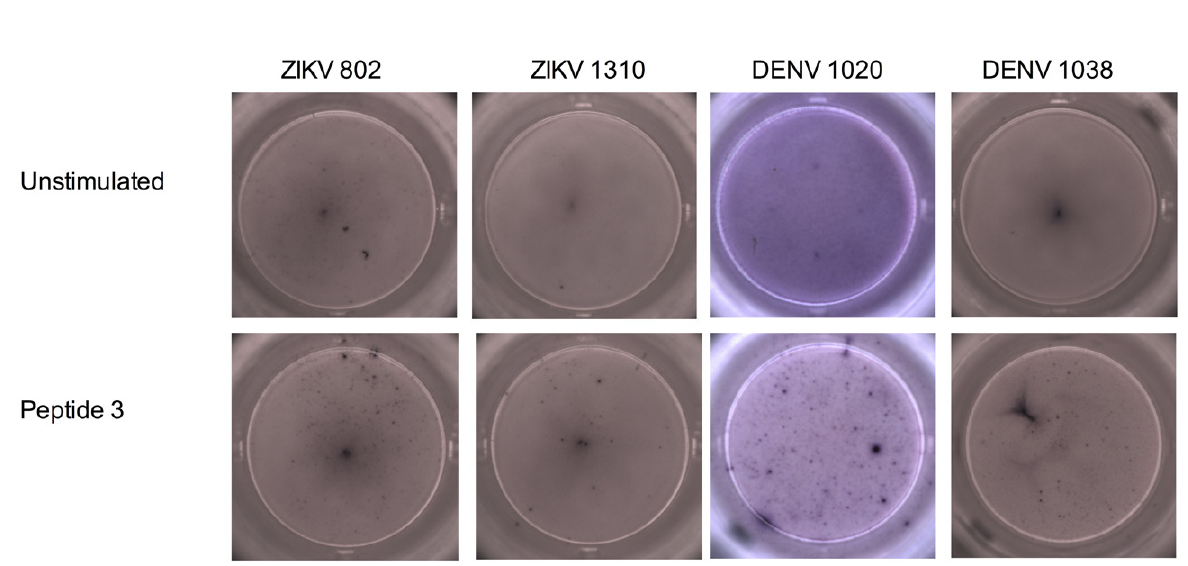
Supplementary Figure 2. IFNgamma ELISPOT results for unstimulated PBMCs (top row) or stimulated with peptide 3 (lower